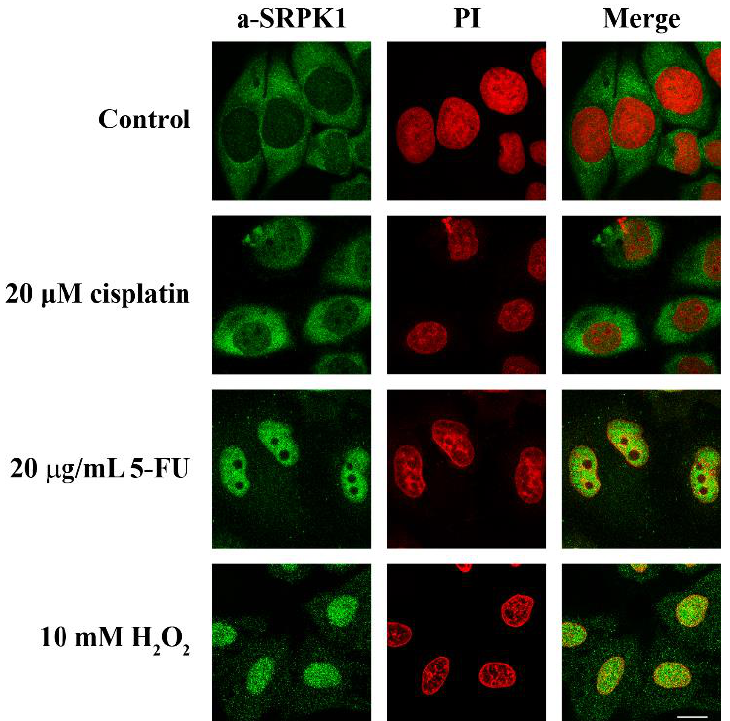
Figure 1. Nuclear translocation of SRPK1 in response to stress agents. HeLa cells were treated with 20 µM cisplatin for 24 h or 20 µg/mL 5-FU for 48 h or 10 mM H 2 O 2 for 1 h and stained for SRPK1 using the anti-SRPK1 monoclonal antibody. Nuclei were stained with propidium iodide (PI). Scale bar: 10 µM.